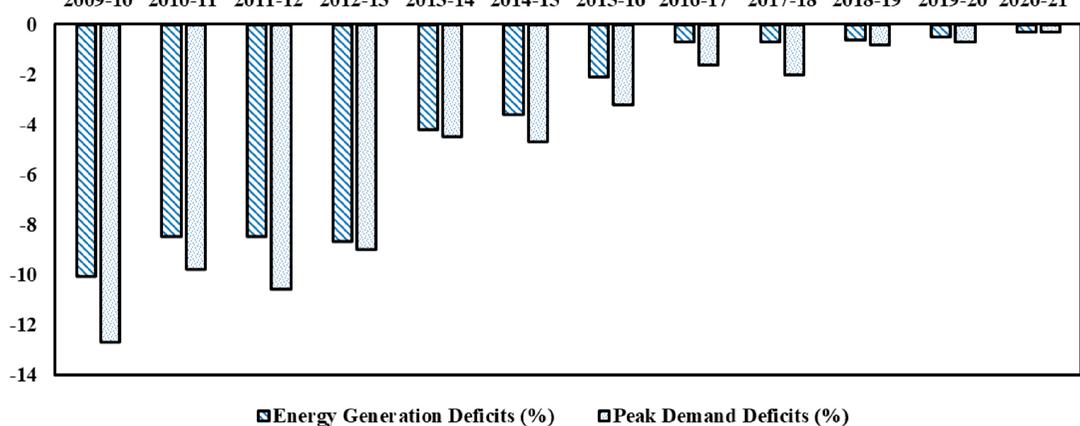
Figure 1. Present Indian Energy scenario: power generation and peak demand deficit from 2009–2021 as per the Central Electricity Authority (CEA).